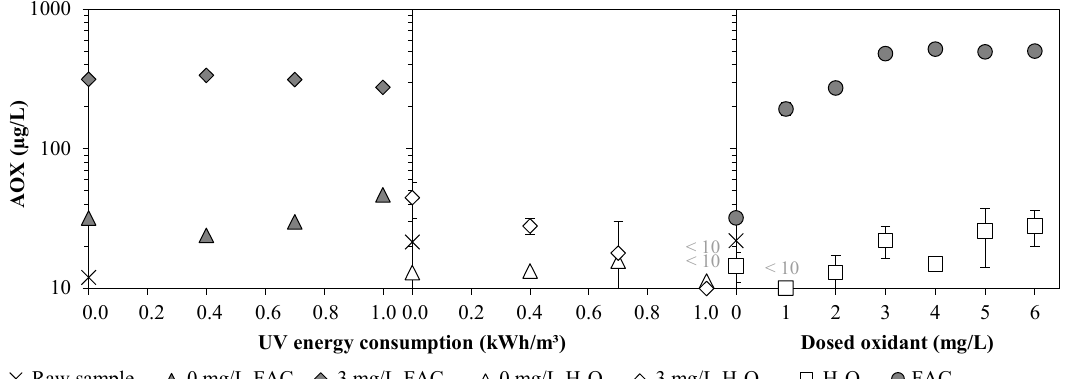
Figure 4. ( Left , Middle ) (Experiment 1) Influence of UV/chlorine AOP and UV/H 2 O 2 AOP at 0.0, 0.4, 0.7, and 1.0 kWh/m 3 UV energy consumption (1 m 3 /h, 0–1 kW) on AOX concentration in WWTE at oxidant concentrations of 0 and 3 mg/L; and ( Right ) (Experiment 2) influence of UV/chlorine AOP and UV/H 2 O 2 AOP at 0.4 kWh/m 3 UV energy consumption (1 m 3 /h, 0.4 kW) on AOX concentration in WWTE as a function of oxidant concentration.